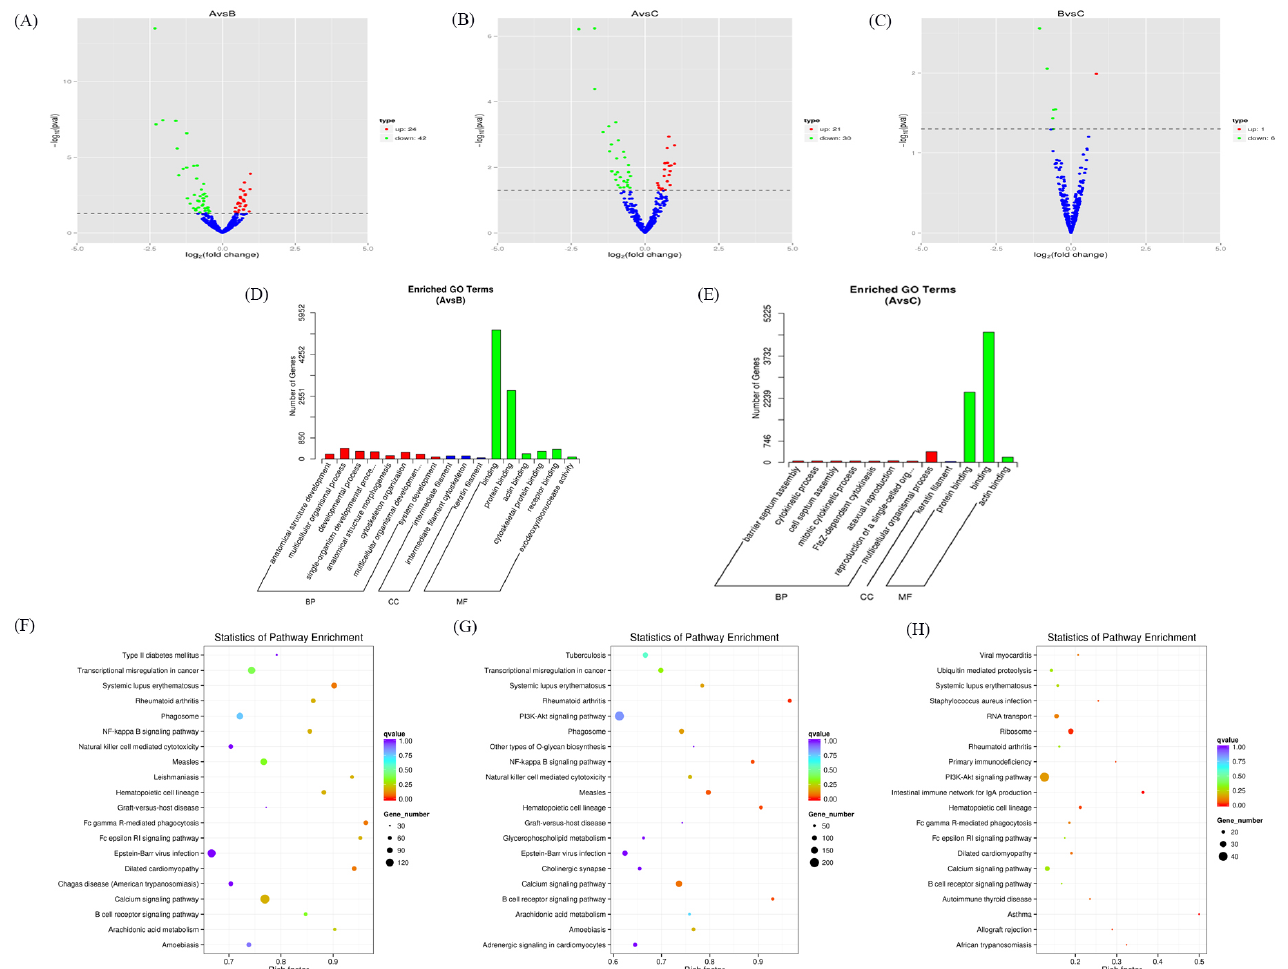
Figure 2. Expression profiles of differentially expressed miRNAs. ( A – C ) Volcano plot of differentially expressed miRNAs in AvsB group ( A ), AvsC group ( B ), and BvsC group ( C ). ( D , E ) GO analysis for neighbor gene functions of miRNA in AvsB group ( D ) and AvsC group ( E ). ( F – H ) KEGG annotation for neighbor gene functions of miRNA in AvsB group ( F ), AvsC group ( G ), and BvsC group ( H ).